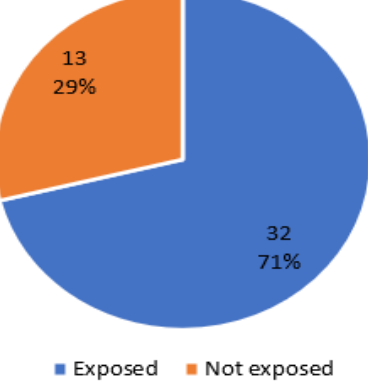
Figure 8. Exposure to coastal hazards.